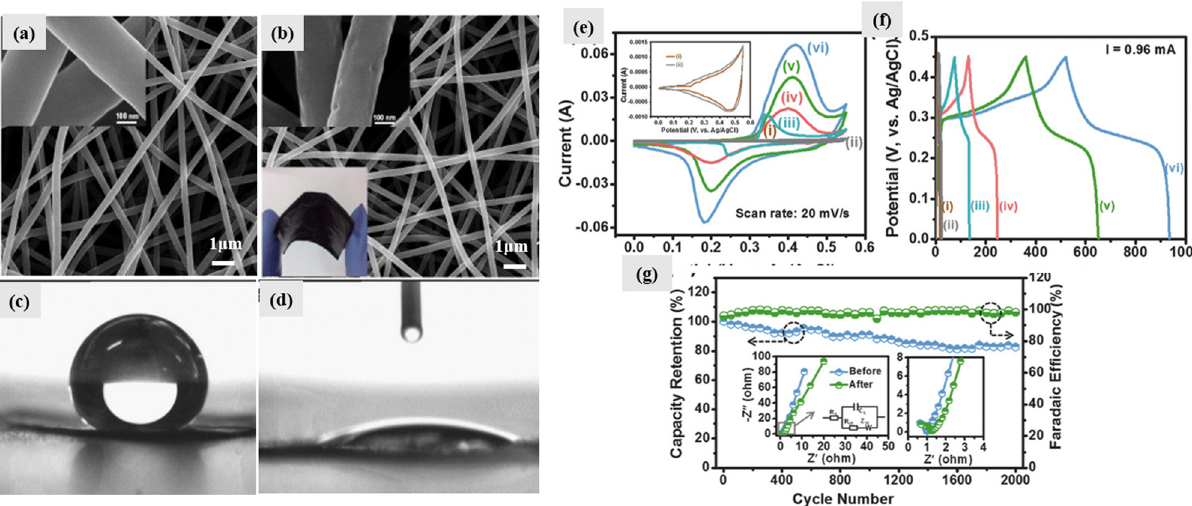
Figure 6: SEM images of ( a ) electrospun carbon nanotube and ( b ) ZnCl 2 - activated carbon nanotube. The high - magni fi cation images are at the upper left of ( a ) and ( b ) . A contact angle test in the surface of the nonactivated CNT ( c ) and active CNT ( d ) [ 22 ] . Copyright 2014, Elsevier. ( e ) cyclic voltammetry ( CV ) curves and ( f ) GCD curves of the treated di ff erent CNTs and their composites. ( g ) Cycling stability of NiO@CNT@CuO [ 28 ] . Copyright 2017,